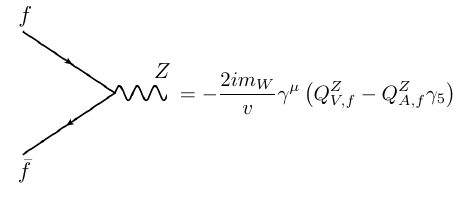
Figure 2. Feynman rule coupling a Z boson to